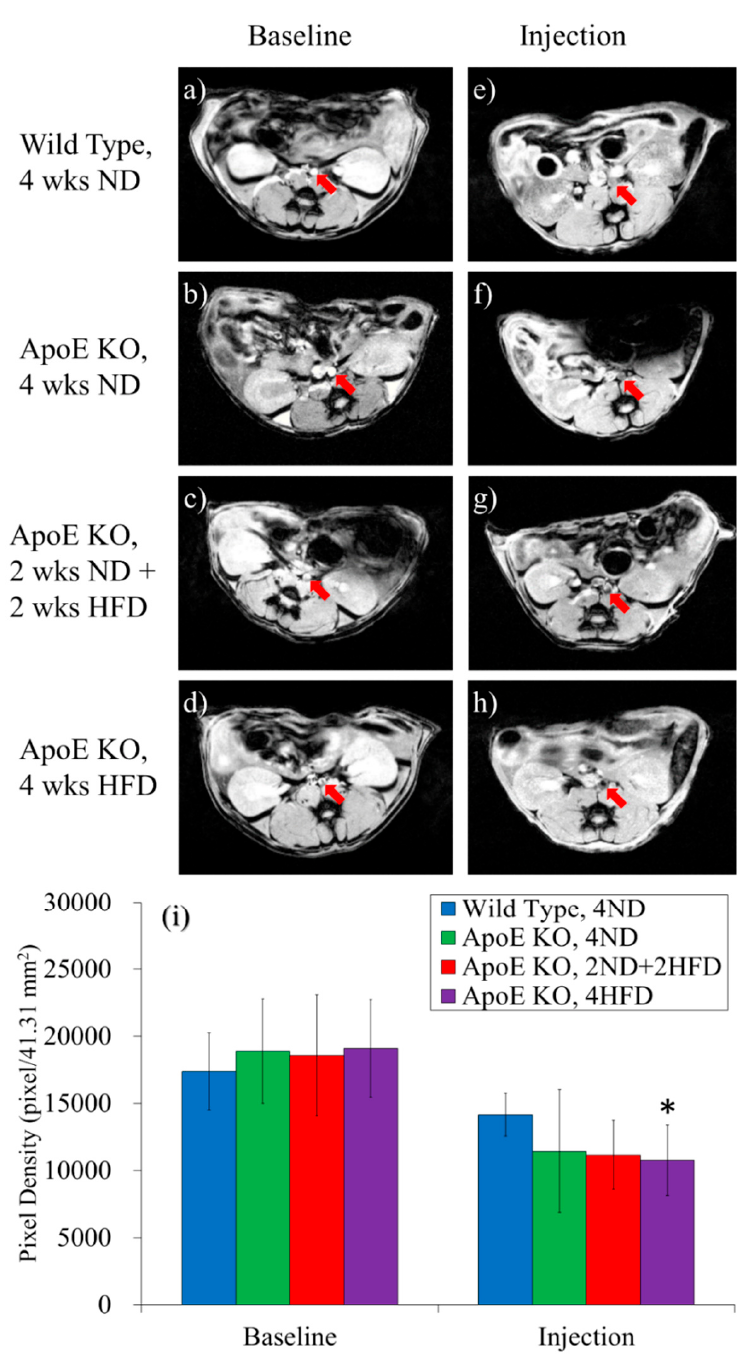
Figure 7. ( a – h ) Magnetic resonance images of mice injected with MCP-1-motif MNPs before and after experiments (wks = weeks); ( i ) Diagram of pixel density throughout the aorta area ( n = 3) (* p < 0.05, compared to the same group of baseline).